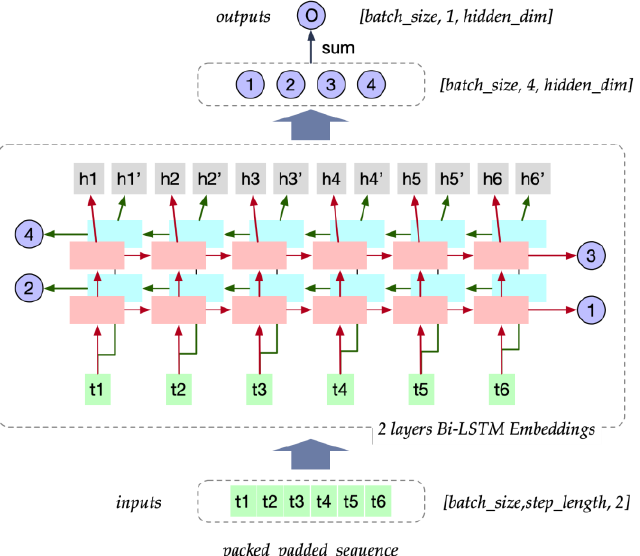
Figure 4. Bi-LSTM structures for trace embedding. CL-MMAD collects outputs of each layer and each direction, concatenates vectors together, and calculates the mean values of all four. We set hidden dimensions equal to 100 in this work.